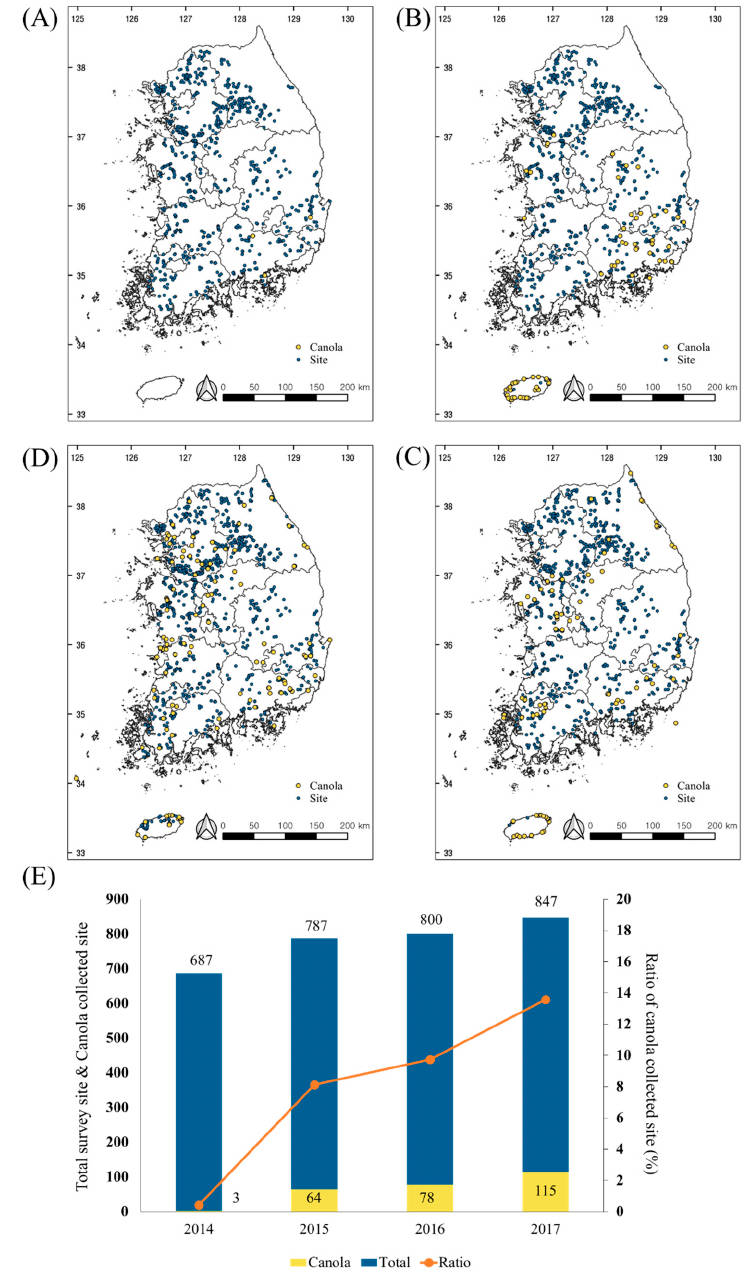
Figure 2. Living modified organism (LMO) monitoring sites in South Korea from 2014 to 2017. The maps show the monitoring survey sites (blue spot) and collection sites of suspicious canola samples (yellow spot) in 2014 ( A ), 2015 ( B ), 2016 ( C ), and 2017 ( D ). The bar graph indicates the number of survey sites and collection sites for the suspicious samples. The red line showed the ratio of suspicious canola collection sites compared to the survey sites ( E